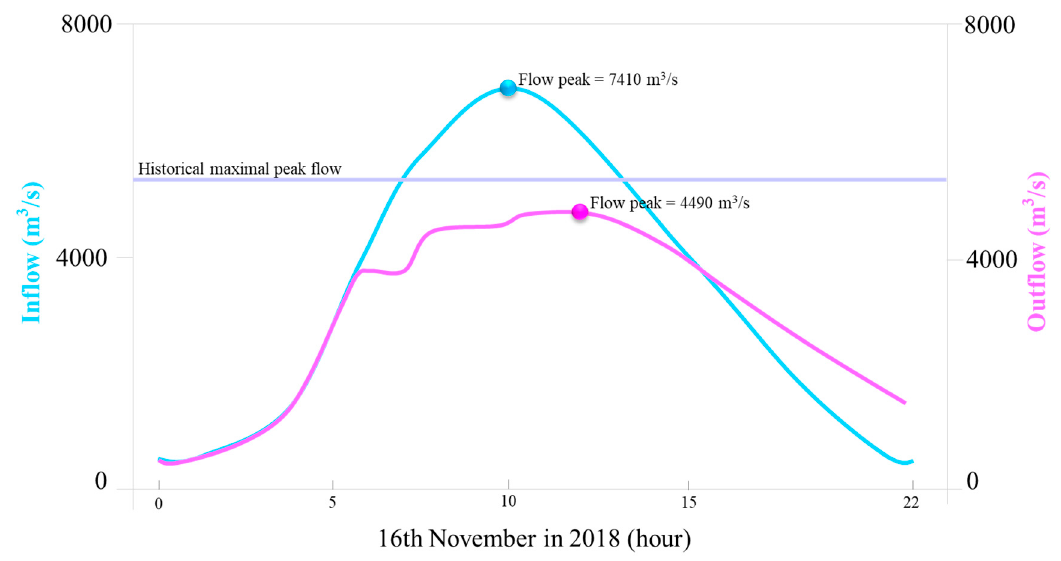
Figure 6. Sketch map of reservoir operation for releasing water in the Liyuan Reservoir.